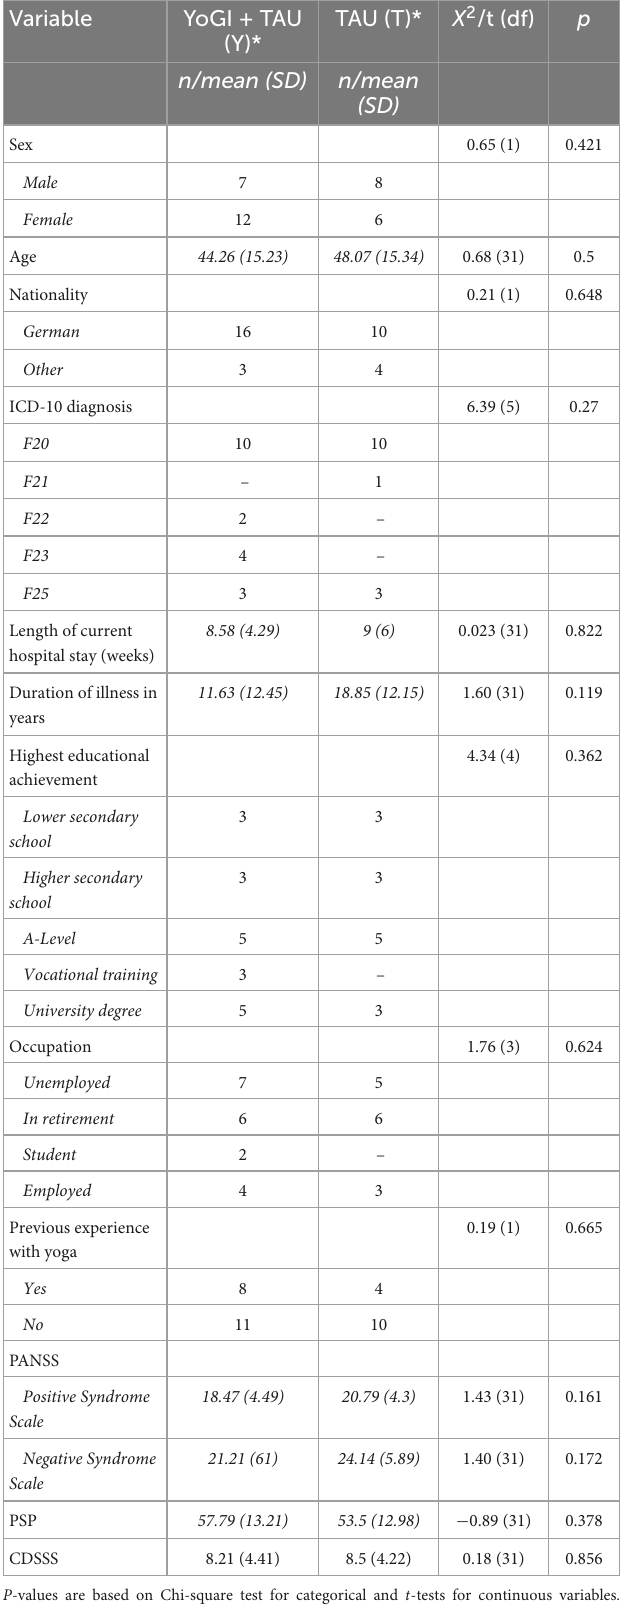
TABLE 2 Sociodemographic variables for both conditions at